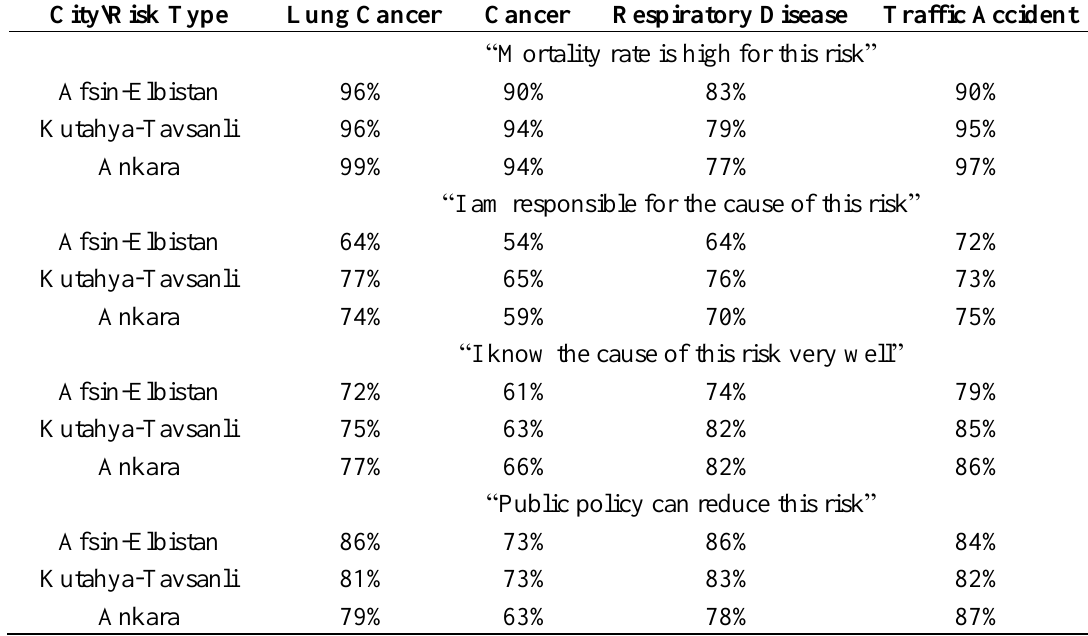
Table 3. Subjective Perception of Risks (% of “Agree” and “Strongly Agree”